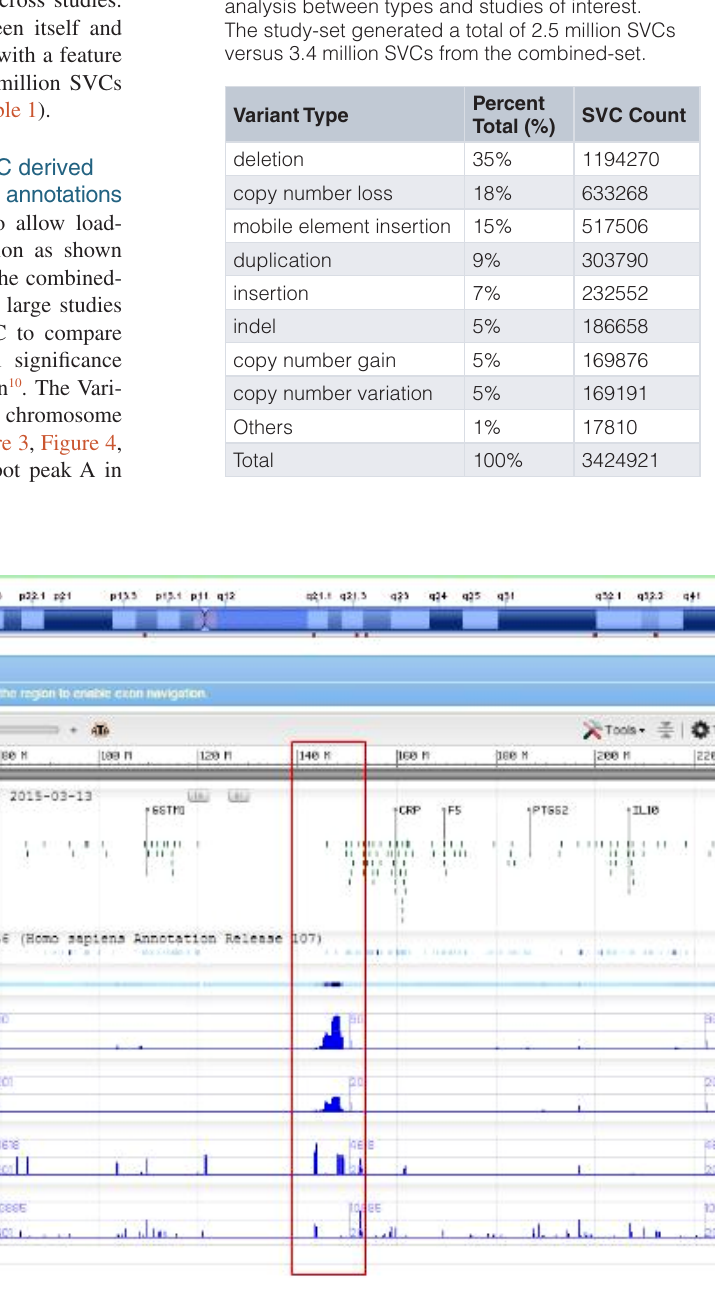
Figure 3. SVC (type=CNV) distribution on chromosome 1 as seen on NCBI Variation Viewer (Variation Viewer - NCBI). Starting from the top: (1) chr 1 sequence, (2) Gene track, (3) ClinVar short variation for dbSNP SNV, (4) ClinVar large variation, (5) ClinGen SVC study-set (dbVar:nstd37) copy number gain, (6) ClinGen SVC study-set (dbVar:nstd37) copy number loss, (7) SVC combined-set for copy number gain with count >= 100, and (8) SVC combined-set for copy number loss with count >= 100. The red box highlights an SVC hotspot region found in ClinGen (dbVar:nstd37) tracks 5 and 6 that correspond with the variants in ClinVar. The scale for SVC count histogram are 1–90 (track 5), 1–20 (track 6), 1–4618 (track 7), and 1–10885 (track